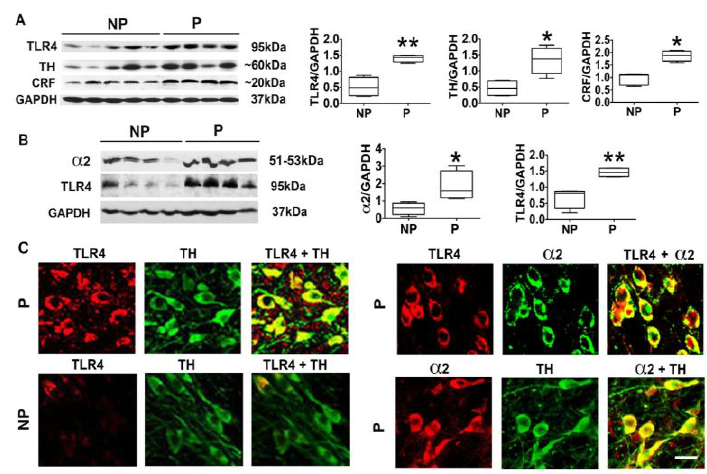
Figure 1. The alcohol-preferring (P) rats have a higher percentage of ventral tegmental area (VTA) TH+ neurons that co-express Toll-like receptor 4 (TLR4) and the γ-aminobutyric acid A receptor (GABA A R) α2 subunit (α2) than alcohol-non-preferring (NP) rats. ( A ) VTA micropunches were collected from the naïve (not drug-exposed) NP ( n = 5) and P ( n = 4) rats, and protein extracts were immunoblotted with antibodies to TLR4, tyrosine hydroxylase (TH), corticotropin-releasing factor (CRF), and GAPDH used as gel loading control. The results are expressed as densitometric units normalized to GAPDH ± SEM, as described in Section 2, and each lane represents an animal. The TLR4, TH, and CRF levels are higher in the P rats than the NP rats. (* p ≤0.05; ** p ≤0.01 by t -test). ( B ) Protein extracts duplicate VTA micropunches from the NP ( n = 4) and P ( n = 4) rats were immunoblotted with α2, TLR4, and GAPDH antibodies, and the results were quantitated as described above. The α2 and TLR4 levels are higher in the P rats than the NP rats. (* p ≤0.05; ** p ≤0.01 by t -test). ( C ) VTA sections from the P and the NP rats ( n = 5/group) were stained in double immunofluorescence with antibodies to (i) TLR4+TH, (ii) TLR4+α2, or (iii) TH+α2, examined by confocal microscopy and Z-stack imaging. Scale bars are 20 μm.